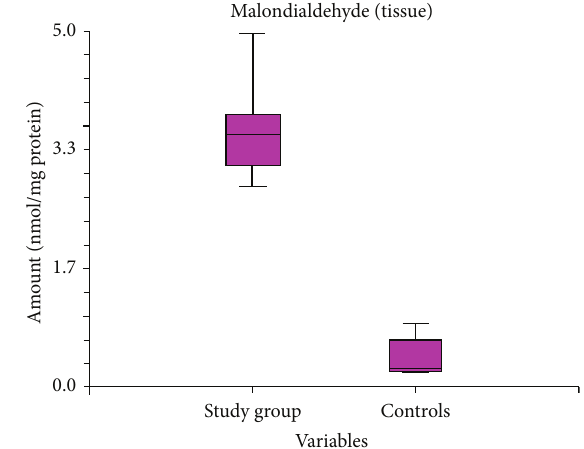
Figure 1: Comparison between MDA tissue levels in diabetics versus controls.